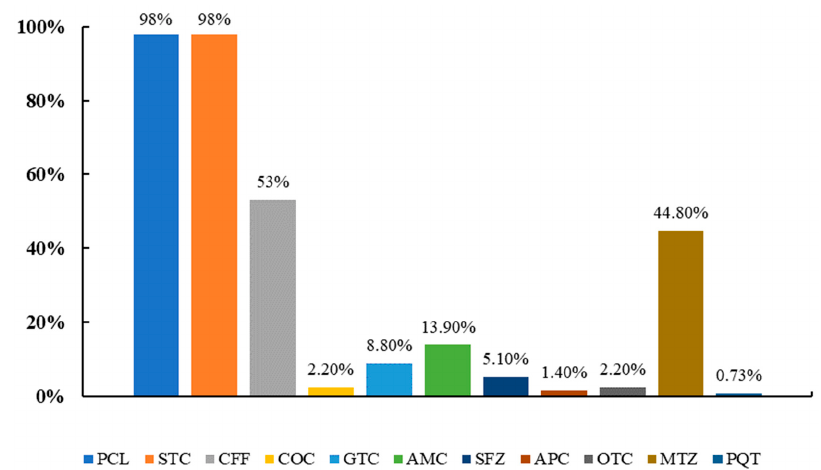
Figure 2. Drug usage rate in dairy farms in Yunnan, China; PCL = Penicillin, STC = Streptomycin, CFF = Ceftiofur, COC = Chloromycetin, GTC = Gentamicin, AMC = Avermectin, SFZ = Sulfadiazine, APC = Ampicillin, OTC = Oxy tetracycline, MTZ = Metronidazole, PQT = Praziquantel.